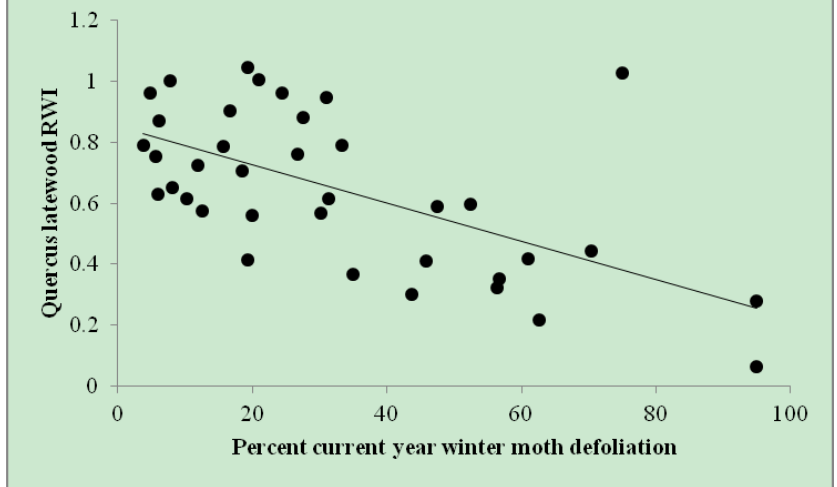
Figure 3. Proportion of Quercus earlywood by Quercus RWI on annual ring widths ( n = 37) among eight trees throughout eastern Massachusetts from 2005–2010.